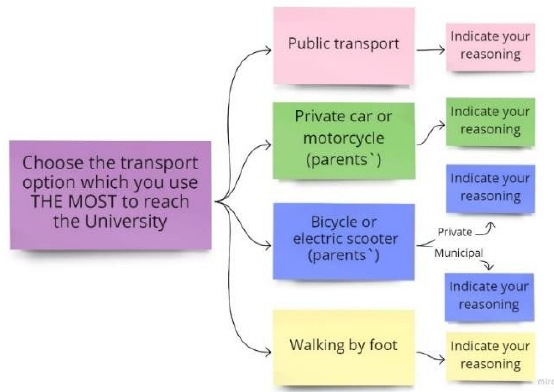
Figure 4. Skip-logic algorithm for questions of “transport category”. Figure 4. Skip ‐ logic algorithm for questions of “transport category”.